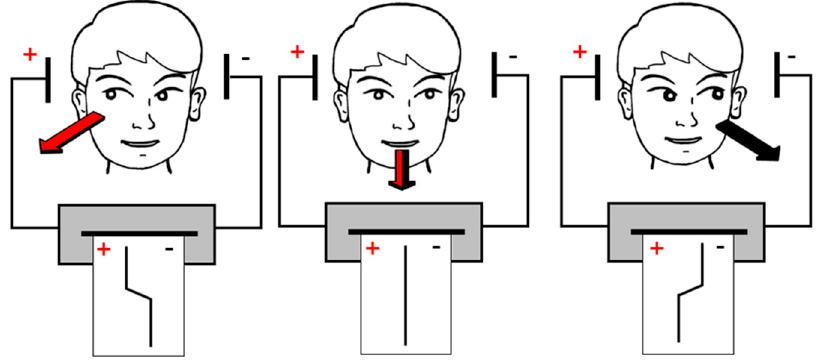
Figure 1. The corneo-retinal potential changes according to horizontal eye movement.